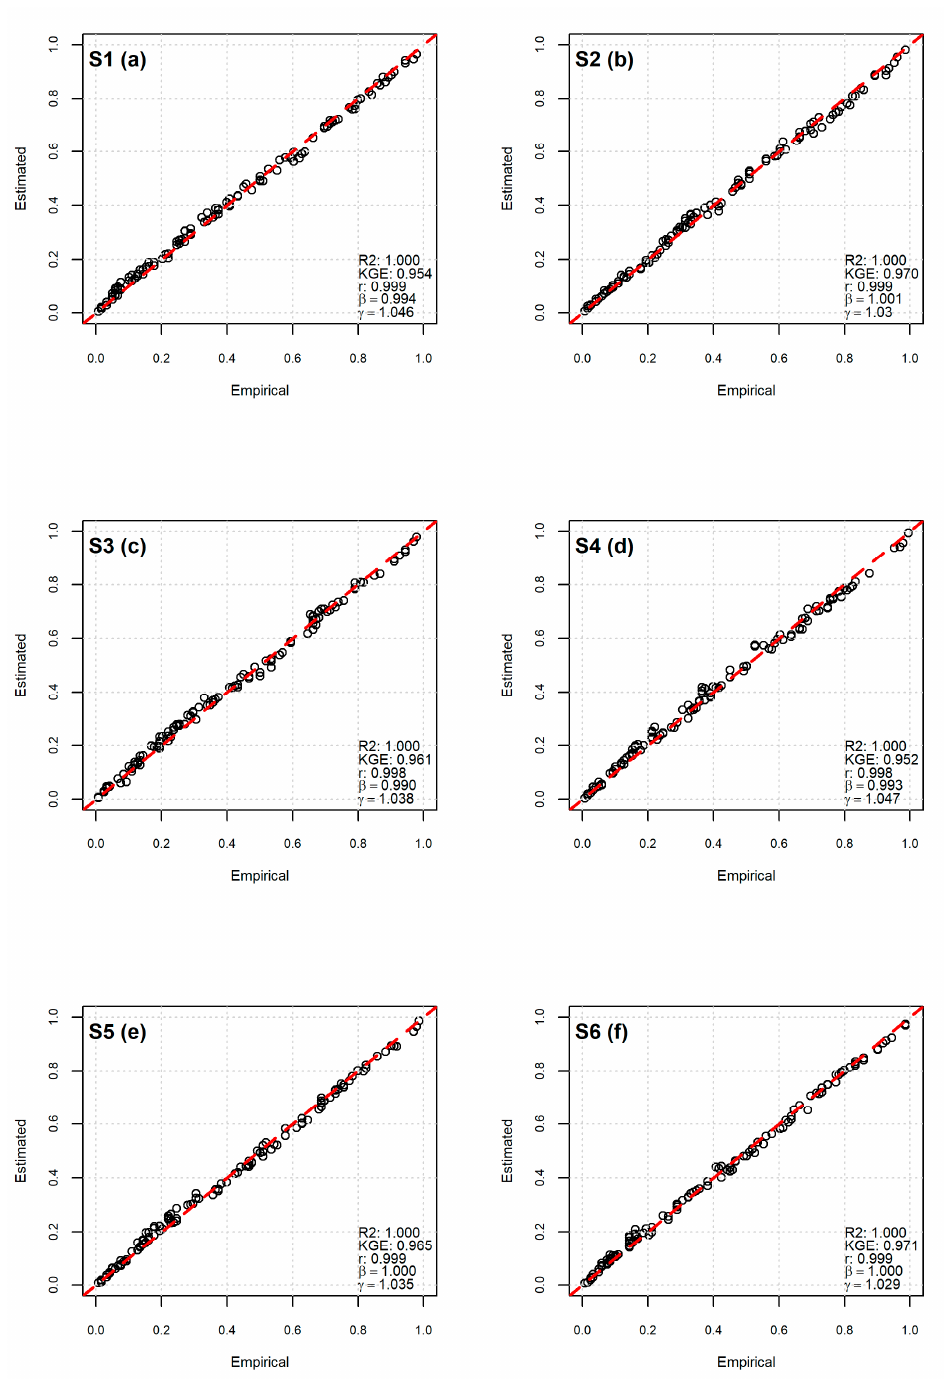
Figure 3. P-P Plot of SSMI3-P for summer months to visually evaluate the goodness of fit (GOF) of KDE ( a – f ).